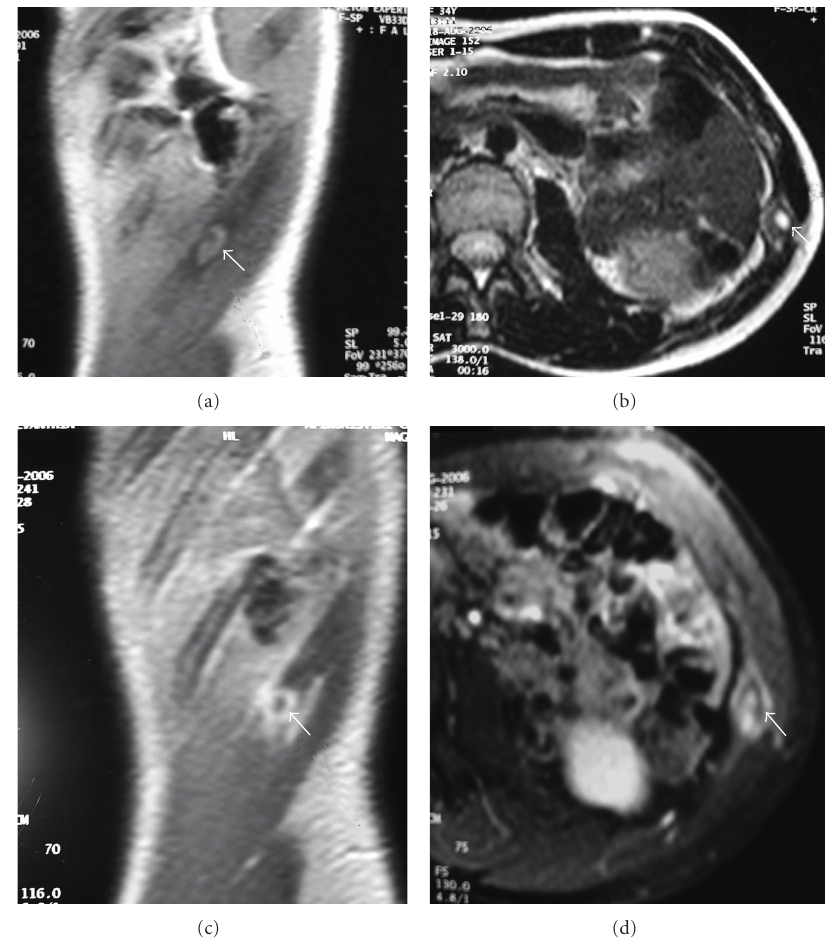
Figure 3: MR imaging of the tumor (arrows). (a) T1W, sagittal section shows an ovoid lesion with intermediate signal intensity, slightly higher than that of muscle. (b) T2W, axial section shows that the lesion has a high signal center and an intermediate signal periphery. After administration of paramagnetic contrast agent, there is both central and peripheral-periosteal enhancement. ((c) sagittal T1W+CM, (d) axial T1W FatSat + CM). The perilesional soft tissues show no signs of invasion. The findings are atypical.